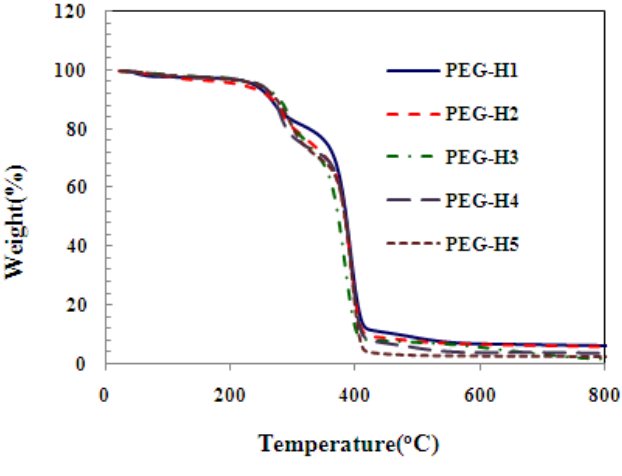
Table 2. Critical values of weight loss, T